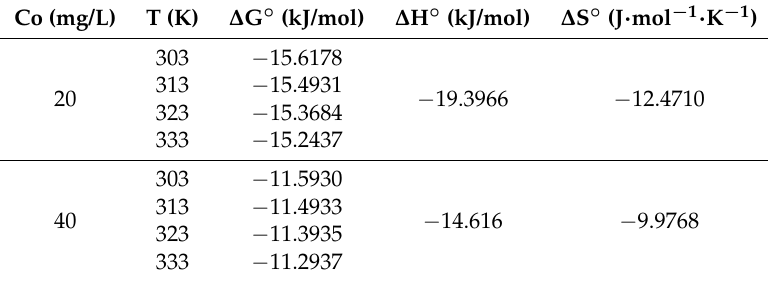
Table 4. Adsorption thermodynamic parameters at different